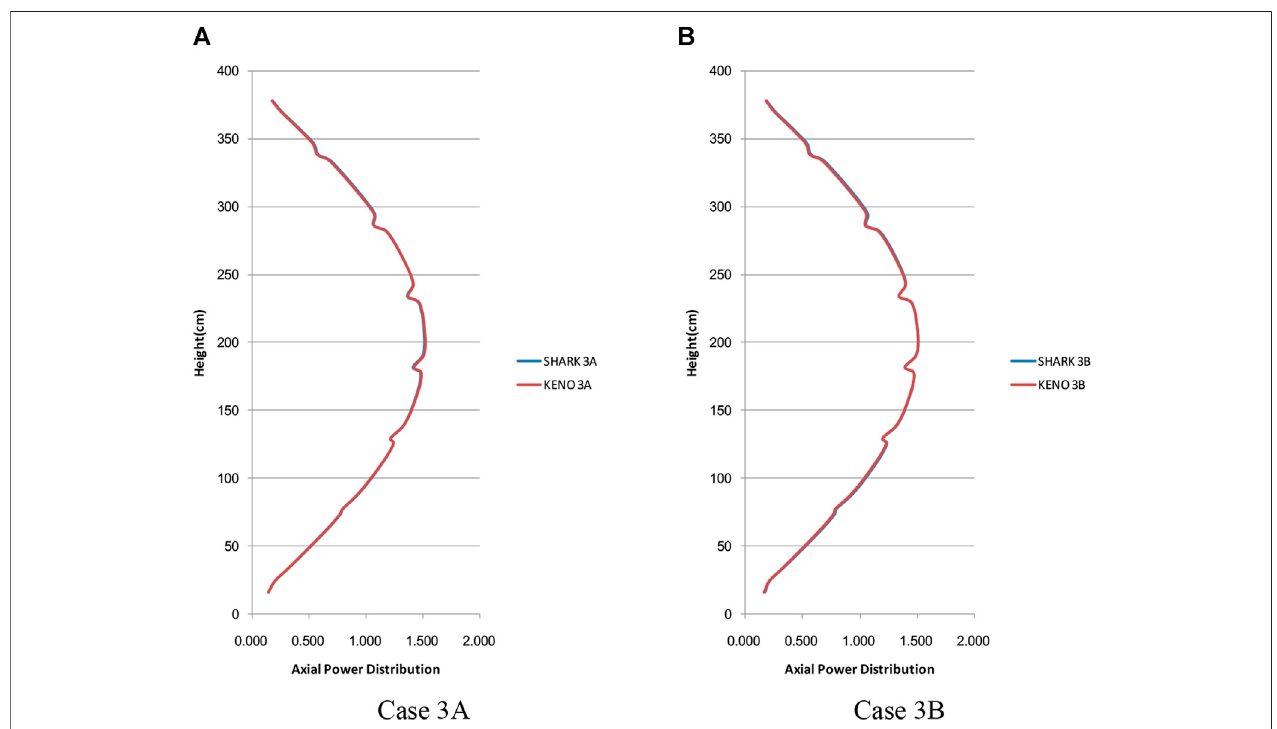
FIGURE 10 | Axial power distribution of VERA Problem